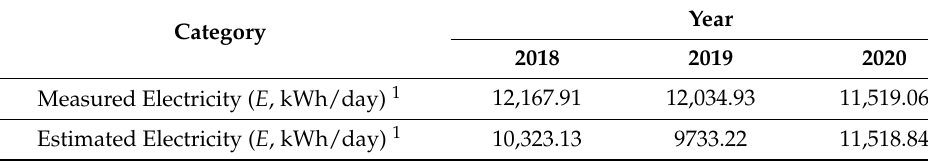
Table 8. The estimated amount of electricity for a 3 MW PV power plant. Table 9. Estimated grain yields (Mg/ha) of all five